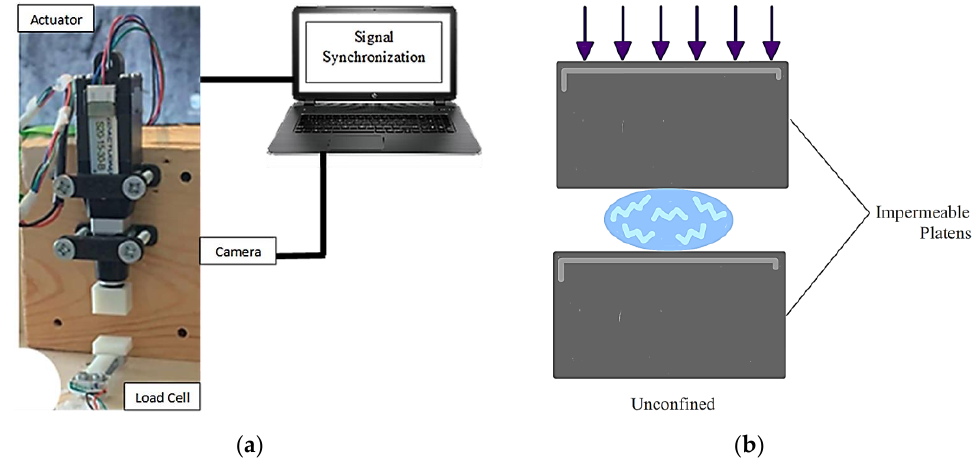
Figure 3. ( a ) Compression testing diagram. ( b ) Diagram of unconfined compression.